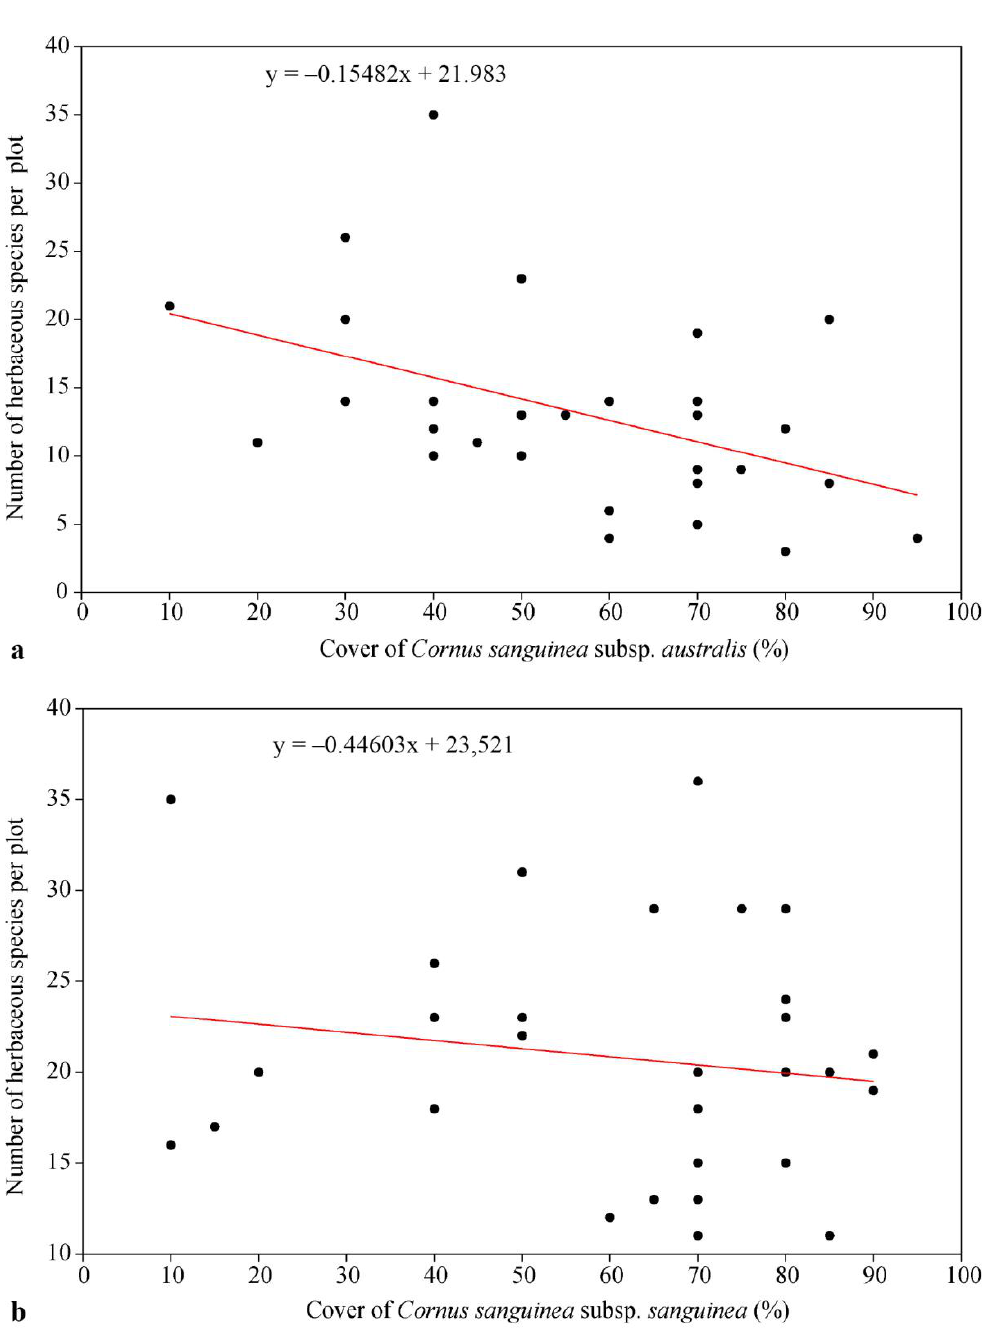
Figure 5. Relationship between the coverage of Cornus sanguinea subsp. australis ( a ) and Cornus sanguinea subsp. sanguinea ( b ) and the number of herbaceous plant species per plot.